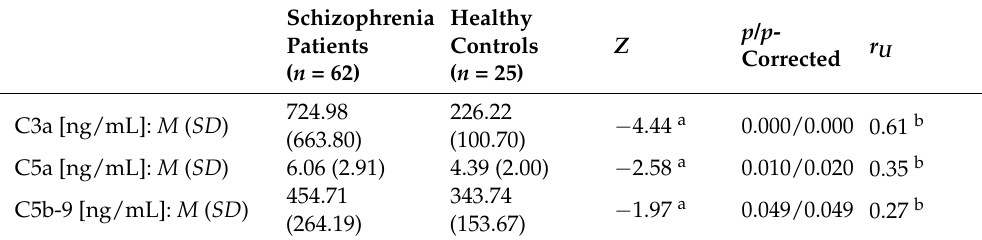
Table 2. Comparisons of the mean levels of complement components between schizophrenia patients and healthy controls.